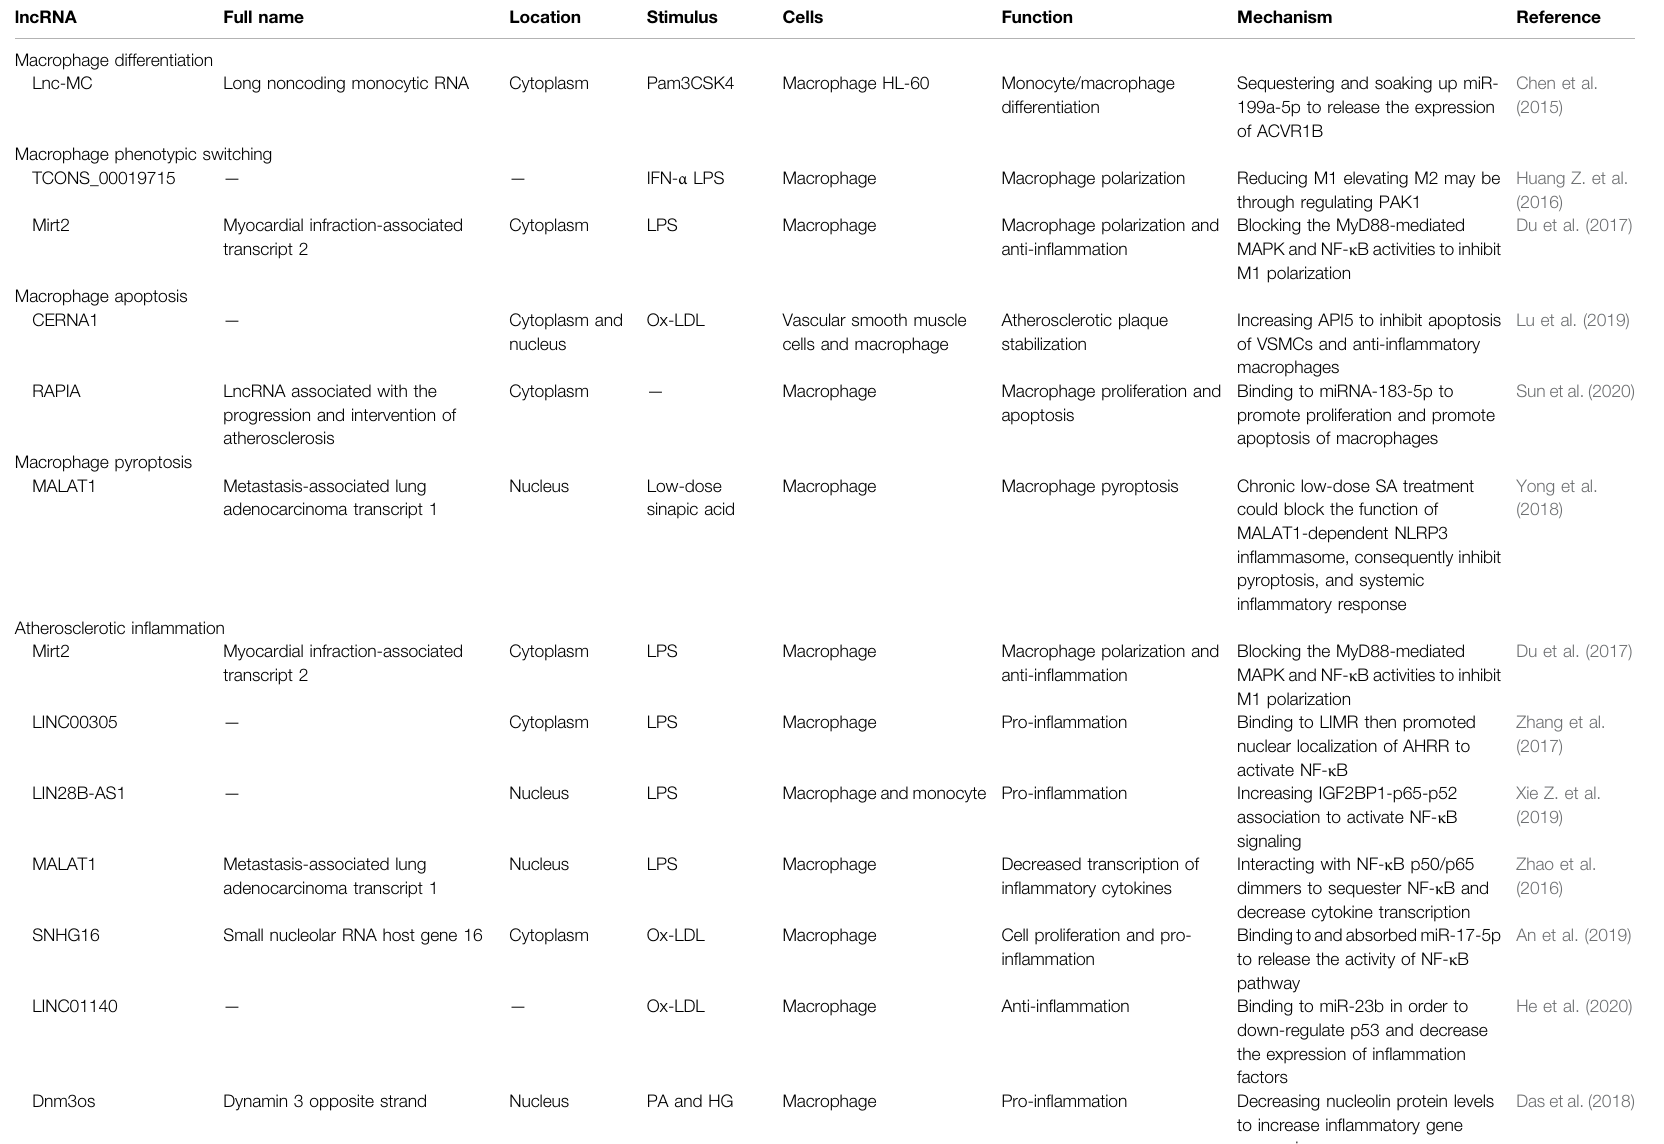
TABLE 1 | Summary of atherosclerosis-related lncRNAs expressed in